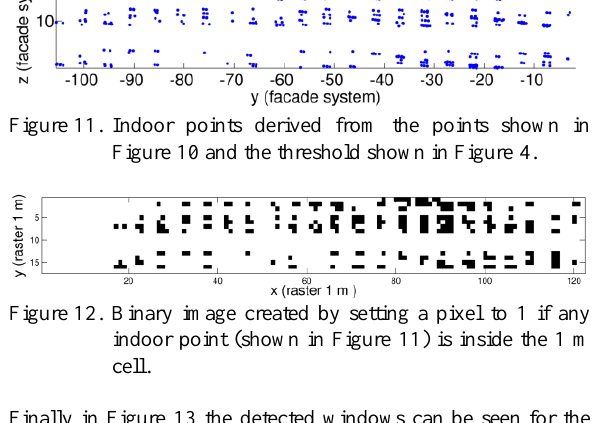
Result of the window detection for the front façade, W = windows (ground truth), I = intrusions (ground truth), T = amount of detected windows, WD = correctly detected windows, ID = detected windows which are actually intrusions, FA = false alarm; )* these values are produced counting double detection of one (large) window/intrusion as one detection.